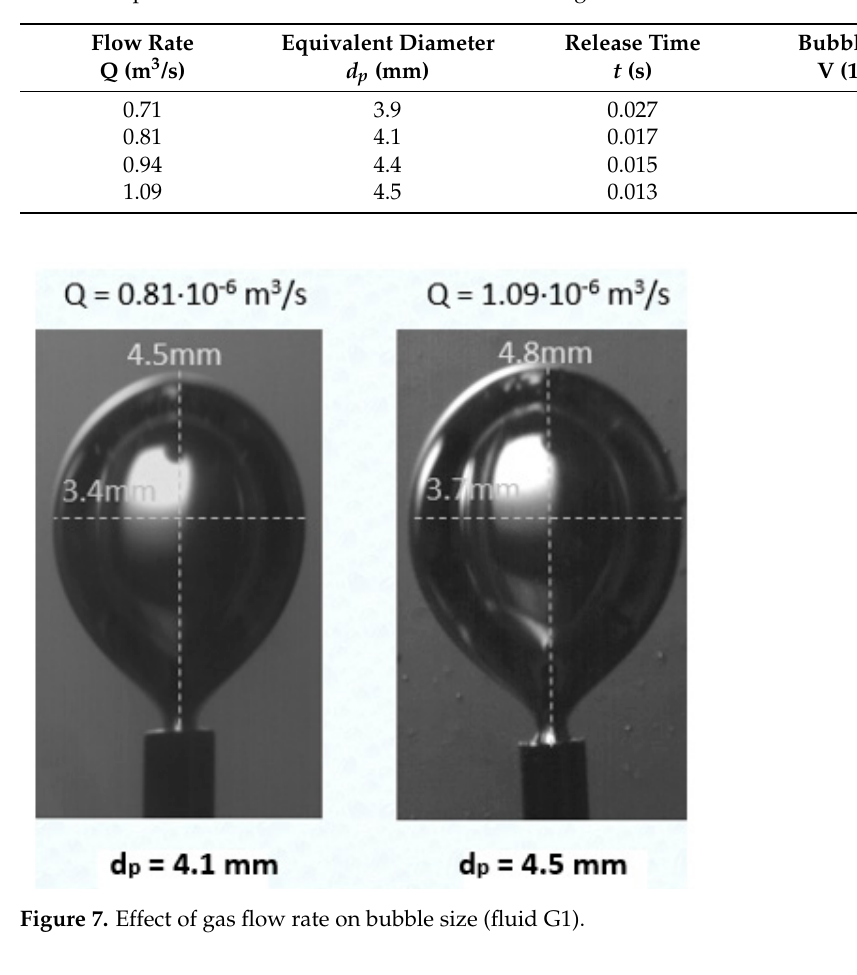
Table 2. Dependence of bubble size and release time on gas flow rate for G1.